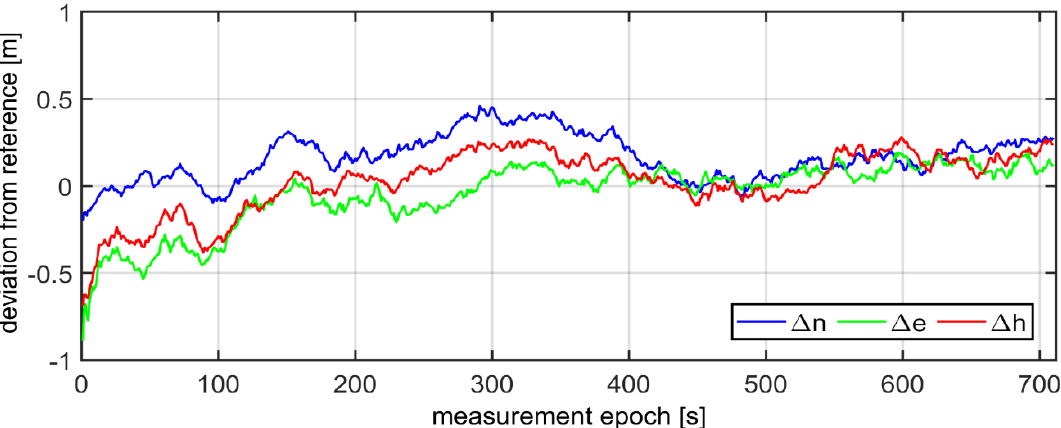
Figure 6. Estimated EGNOS positioning errors determined through internal validation of kinematic positioning, for horizontal coordinates ( ∆𝑛,∆𝑒 ) and the vertical coordinate (∆ℎ ).